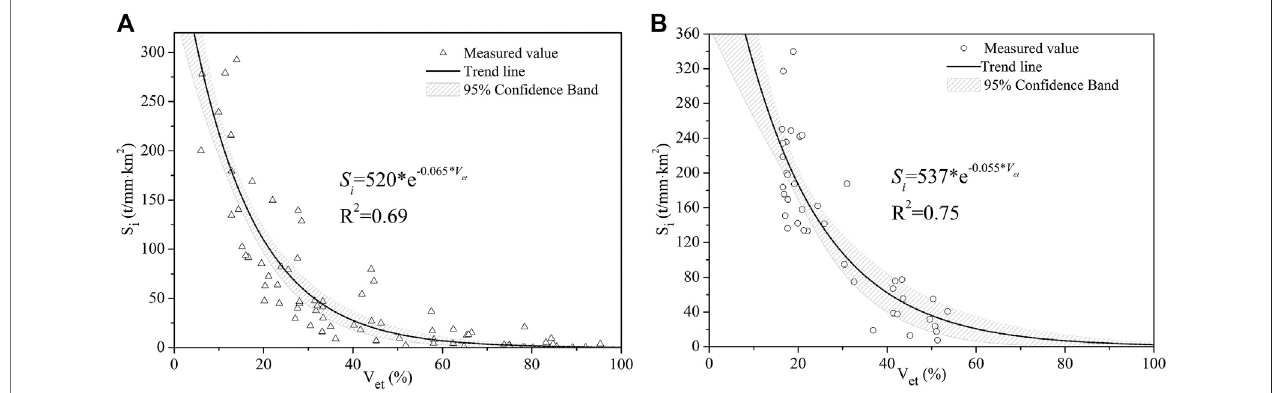
FIGURE 4 | The relationships between S i and V et in the loess hilly area (A) and feldspathic sandstone area (B) .